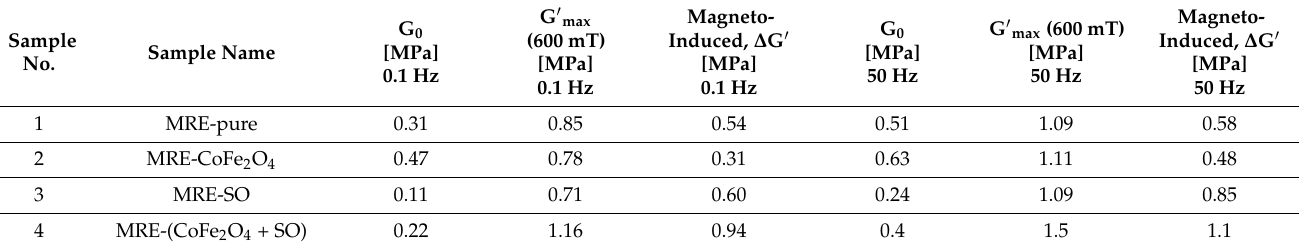
Table 5. The rheological properties of MRE samples under frequency sweep.